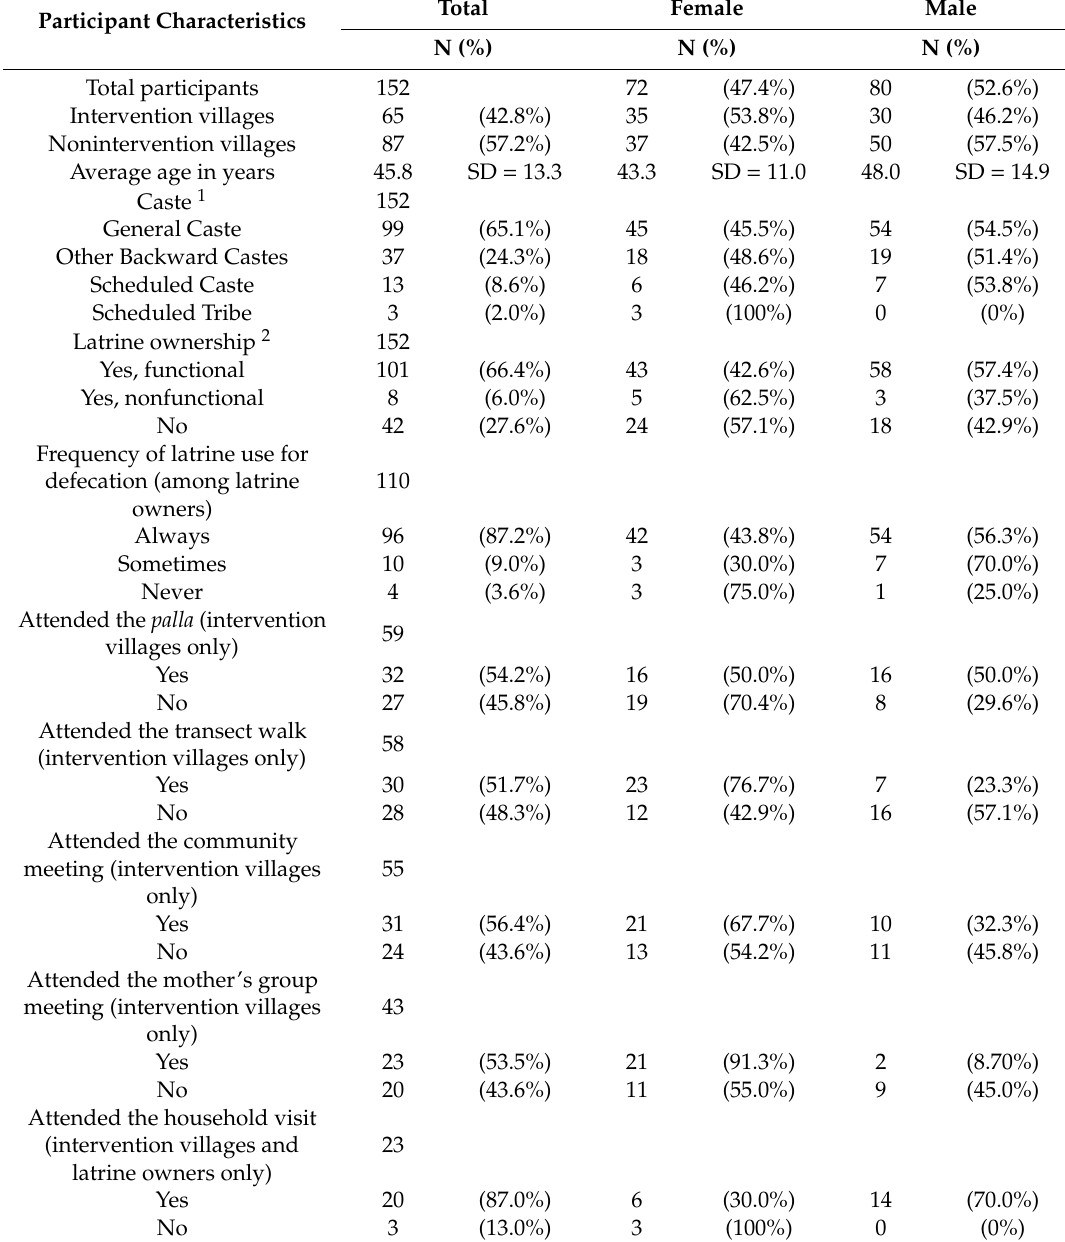
Table 1. Demographic Information of Focus Group Participants in Total, and by